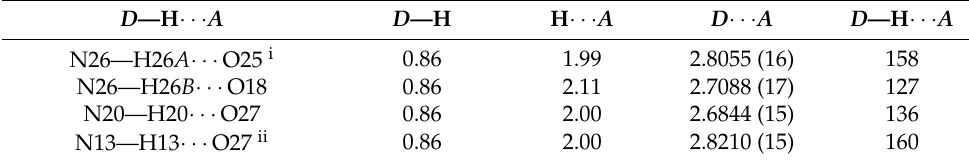
Table 2. Hydrogen-bond geometry (Å, ◦ ) for 1 .